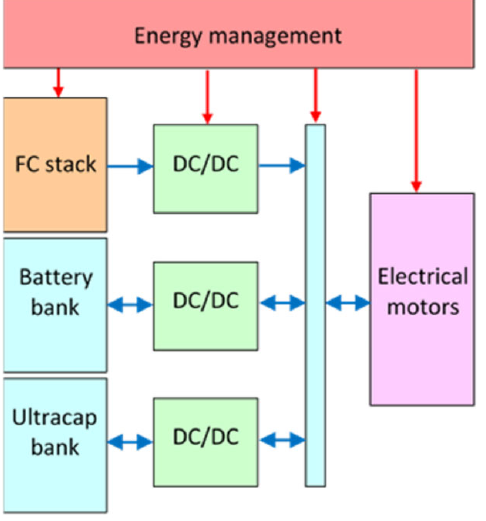
Figure 5. A powertrain of an FCEV.